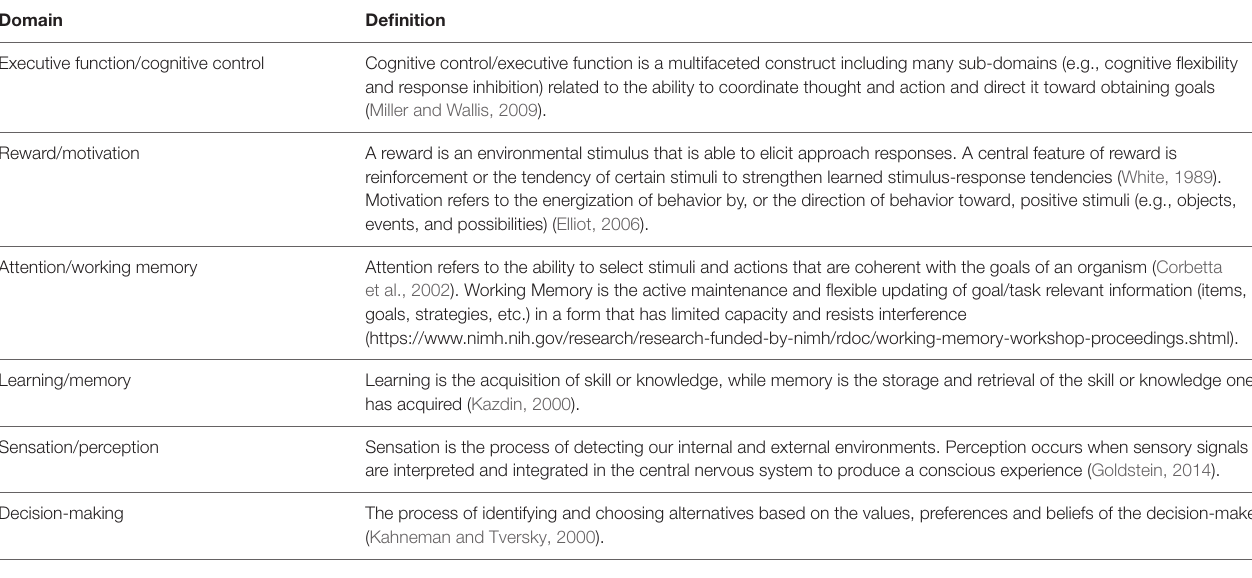
TABLE 1 | Summary of neuropsychological domains.